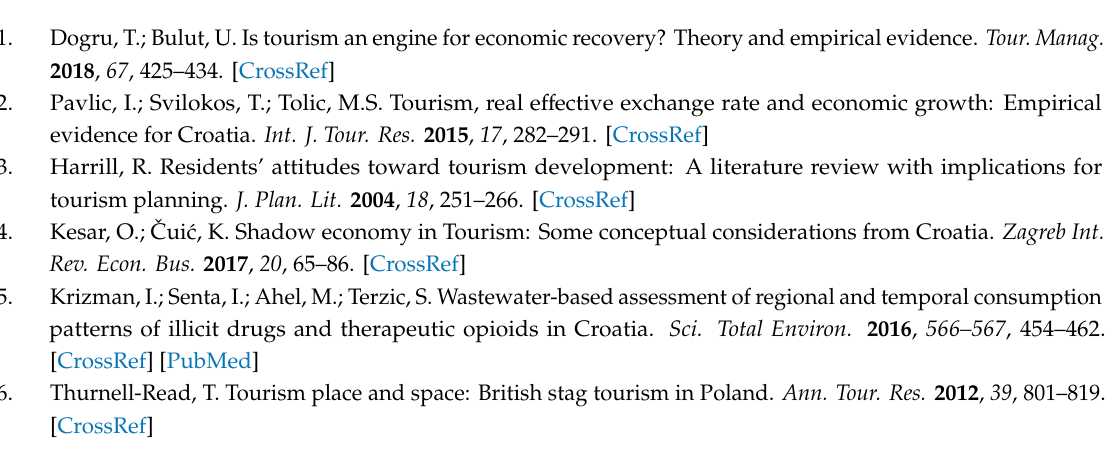
Table S1: Descriptive statistics for variables obtained at baseline and